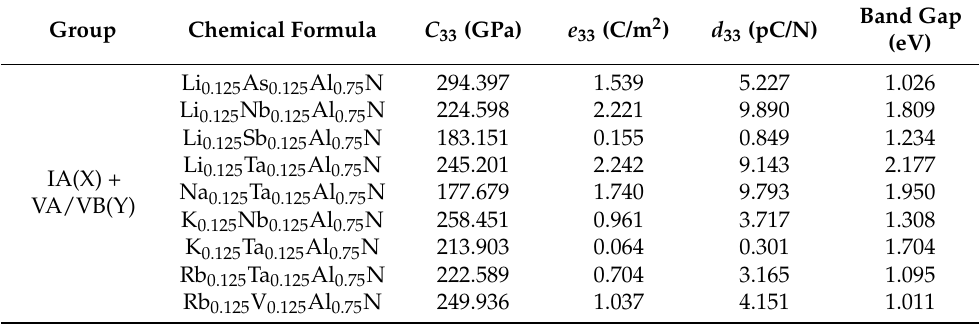
Table 1. Properties of the e 33 , C 33 , d 33 , and band gap of the 67 dopants considered in this study.